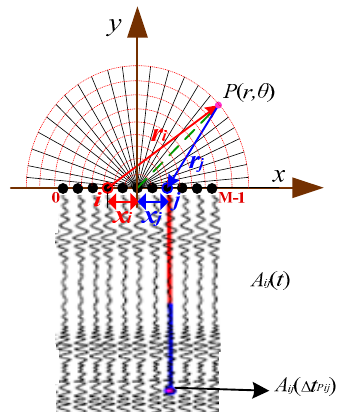
Figure 2. The principle of sampling near-field phased-array ultrasound imaging.